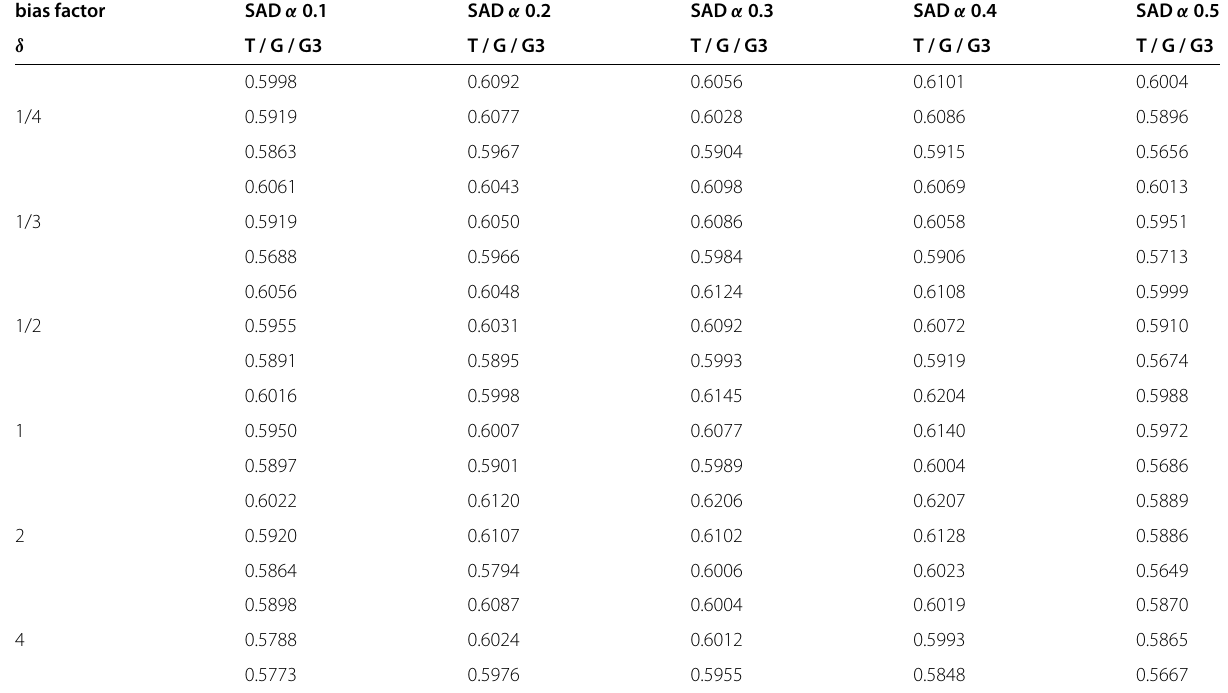
Table 10 A comparison of using different bias factors and SAD dilation-erosion factors on ASR Model 1. ATWV values are evaluated on the SAD segmented dev dataset. “T”, “G” and “G3” represent CNN-TDNNF aligner, GMM-HMM (4 iteration) aligner and GMM-HMM (3 iteration) aligner, respectively bias factor SAD α